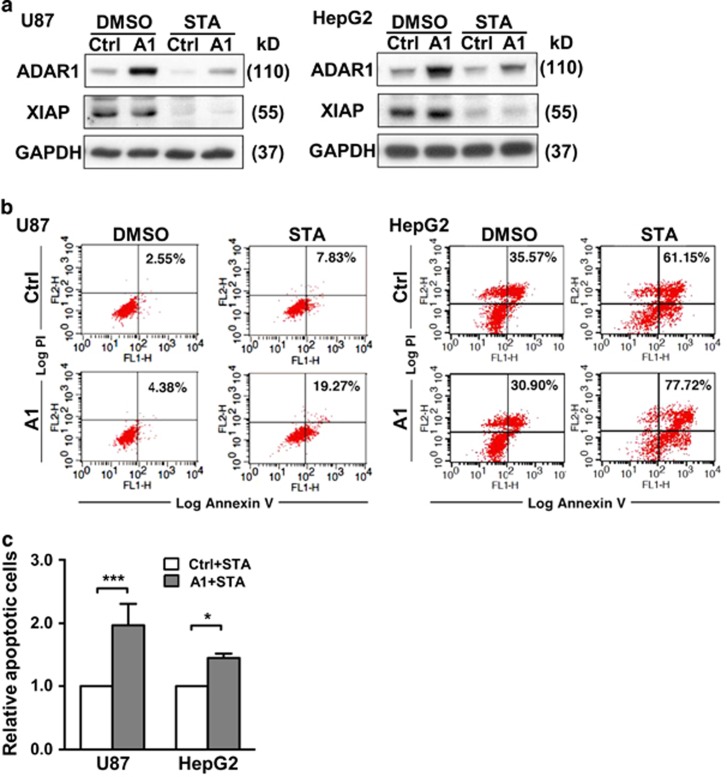
ADAR1 overexpression triggers enhanced apoptosis. (a) Western blot analysis was done on U87 (left) and HepG2 (right) cancer cell lines ectopically overexpressing ADAR1 and treated with STA. The indicated protein expression was examined, with GAPDH being the internal control. (b) The STA-treated cultures from (a) were analyzed for extent of apoptosis by flow cytometry. (c) Bar graph represents quantitatively the percentages of cell death in the STA-treated cultures of control or ADAR1-overexpressing cells, showing means±S.D. of at least three independent experiments. Apoptotic levels were normalized to the Ctrl group (for statistical analyses shown in this figure: NS, not significant or P>0.05; *P<0.05; **P<0.01; ***P<0.001)